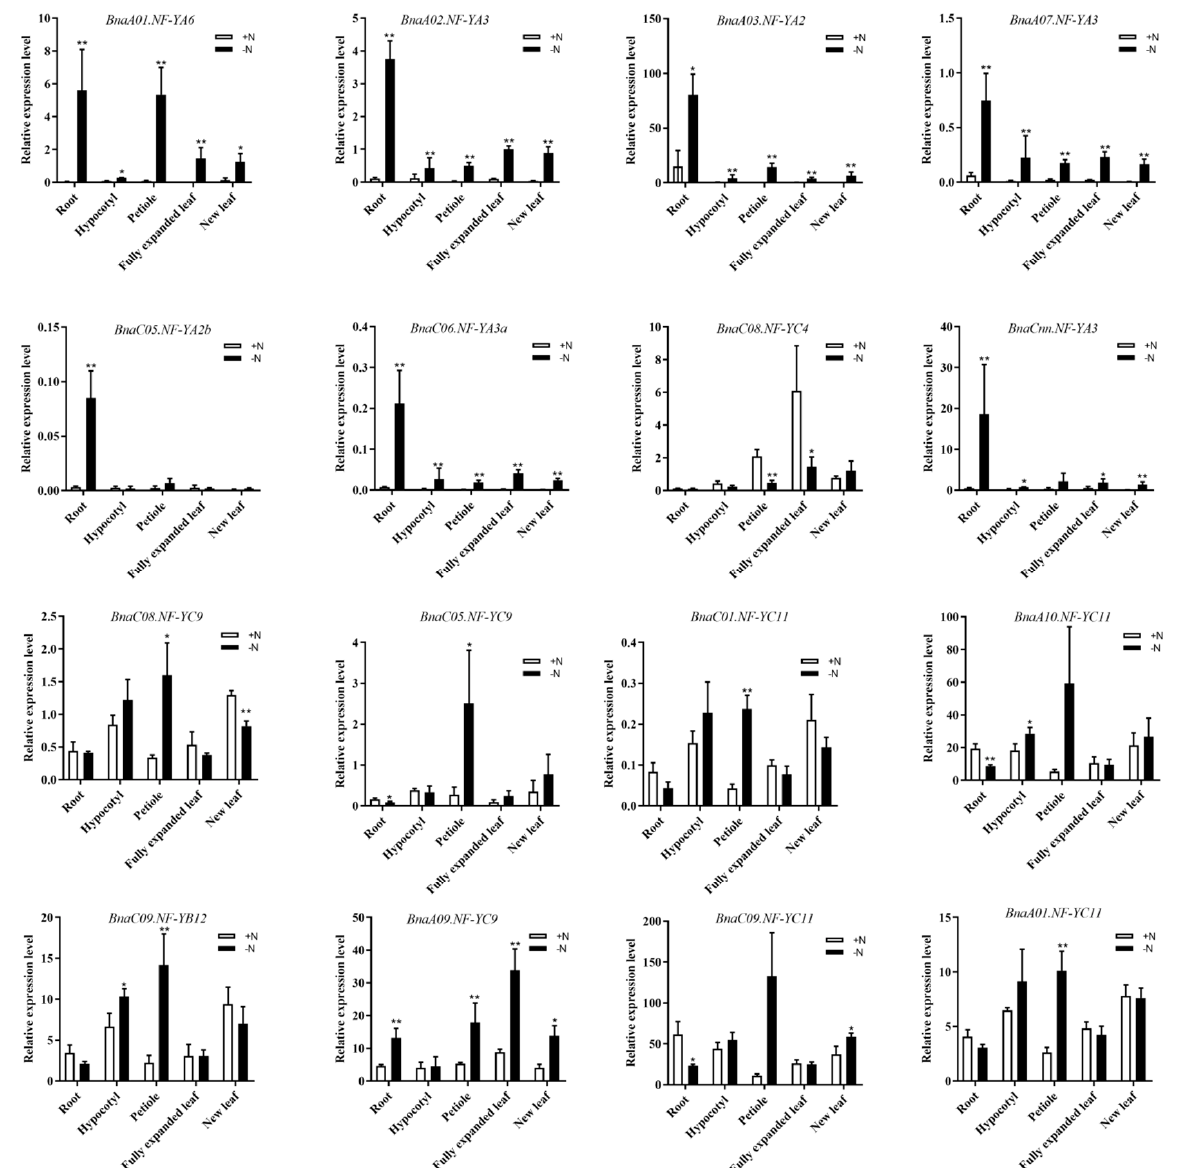
Figure 9. The expression levels of the 16 selected BnaNF-Y genes in five tissues of B. napus in response to nitrogen (N) deficiency by qRT-PCR. Fourteen-day-old rapeseed seedlings were cultivated in a nutrient solution free of N for six days. RNA was extracted separately from five tissues including root, hypocotyl, petiole, fully expanded leaf and new leaf under N sufficient and deficient conditions. +N: N sufficient condition; − N: N free (0 µ M N) condition. Each sample included three independent biological replicates. * and ** indicate significant differences at p < 0.05 and p < 0.01 per student’s t test, respectively.